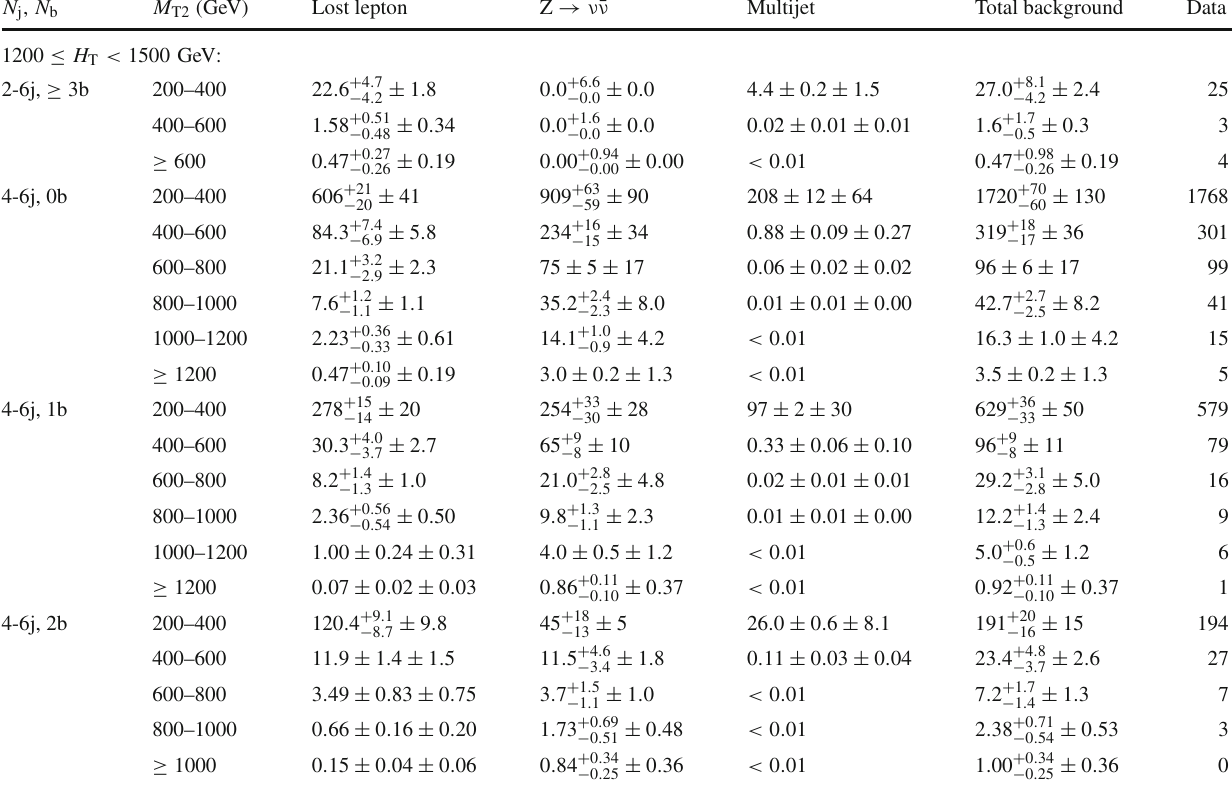
Table 20 Predictions and observations for the 20 search regions with 1200 ≤ H T < 1500 GeV, and 2 ≤ N j ≤ 6 and N b ≥ 3, or 4 ≤ N j ≤ 6. Foreachofthebackgroundpredictions,thefirstuncertaintylistedissta-